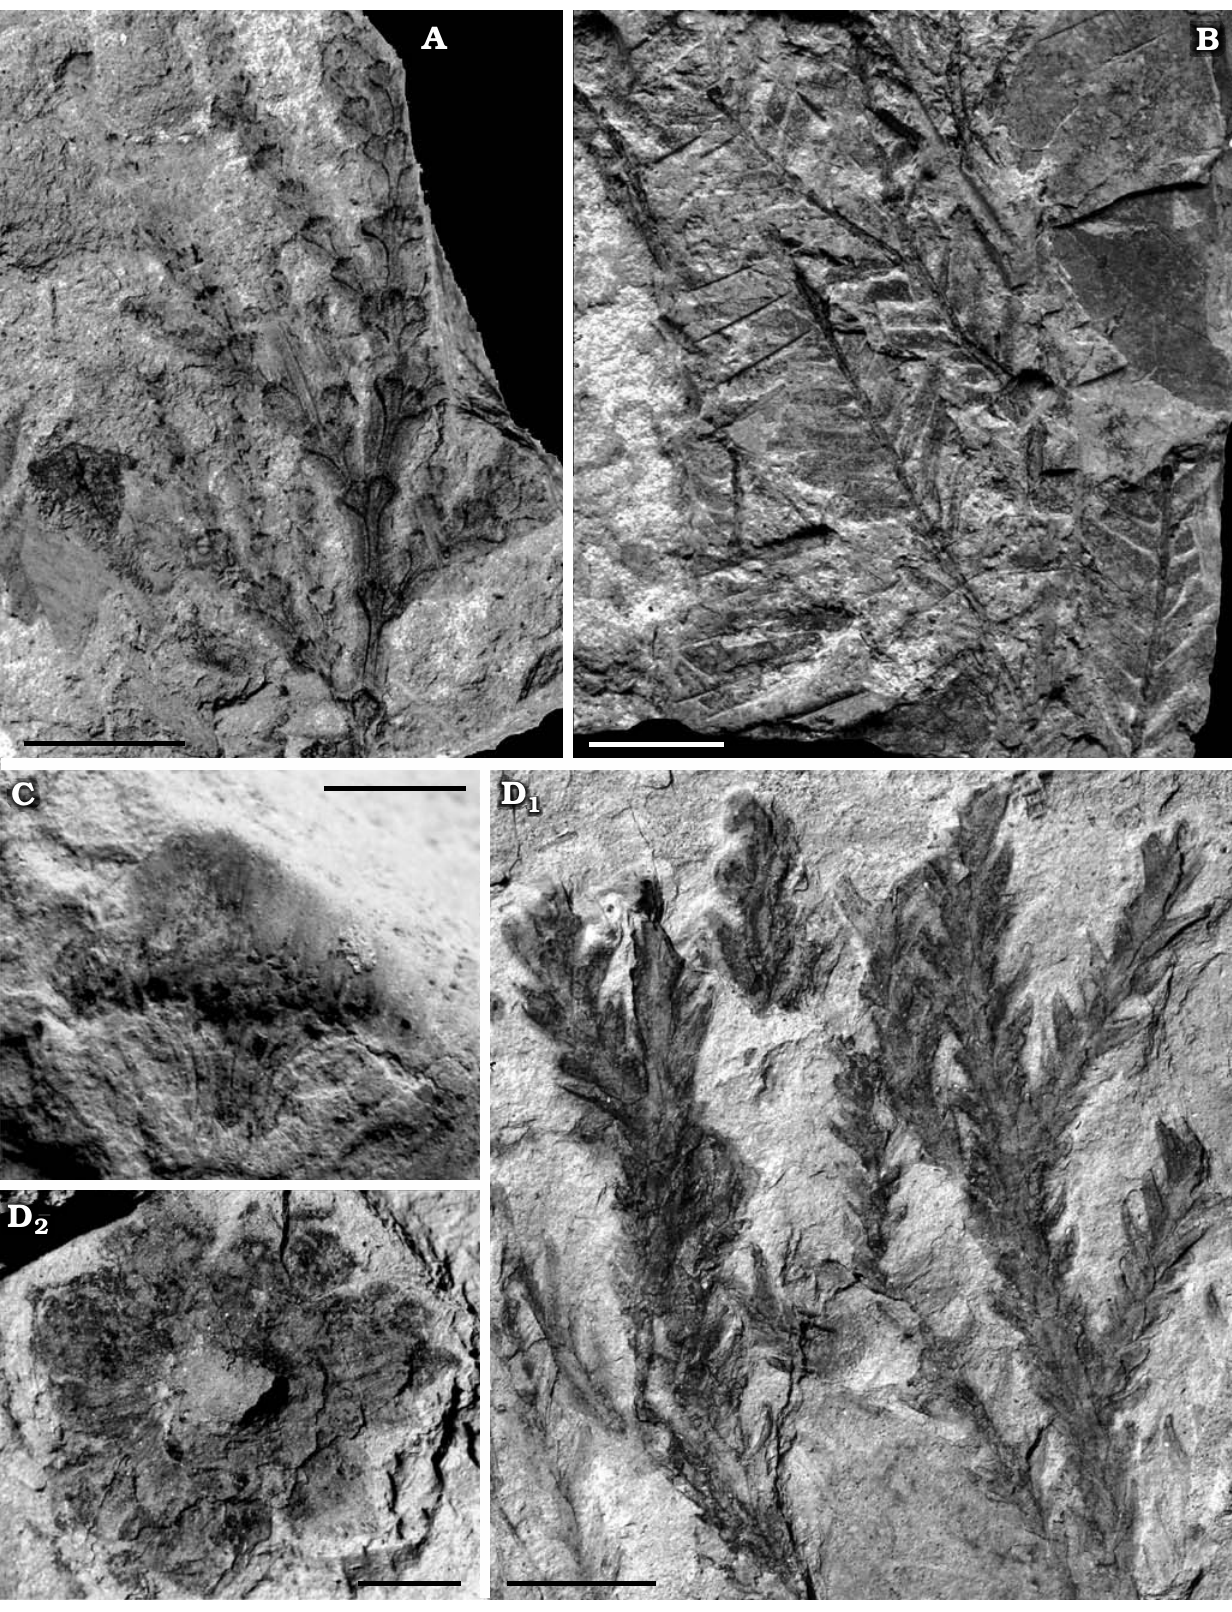
Fig. 2. Conifers impressions from Ł ysa Góra near R ę biszów, Poland, late Oligocene. A . Calocedrus suleticensis (Brabenec, 1909) Kva č ek, 1999, KRAM-P 128/38, twig. B . cf. Tsuga sp., KRAM-P 128/50, twigs. C . Cunninghamia cf. miocenica Ettingshausen, 1872, KRAM-P 128/251, cone scale. D . Cryptomeria cf. rhenana Kilpper, 1968, KRAM-P 128/1; twigs (D 1 ), cone (D 2 ). Scale bars: A, B, D 1 , 10 mm; C, D 2 , 5